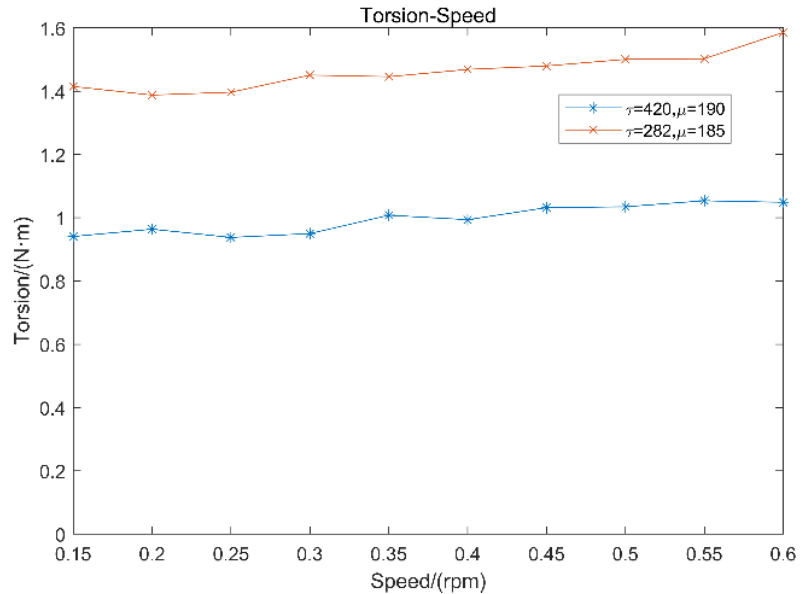
Figure 7. Experimental rheometer data.